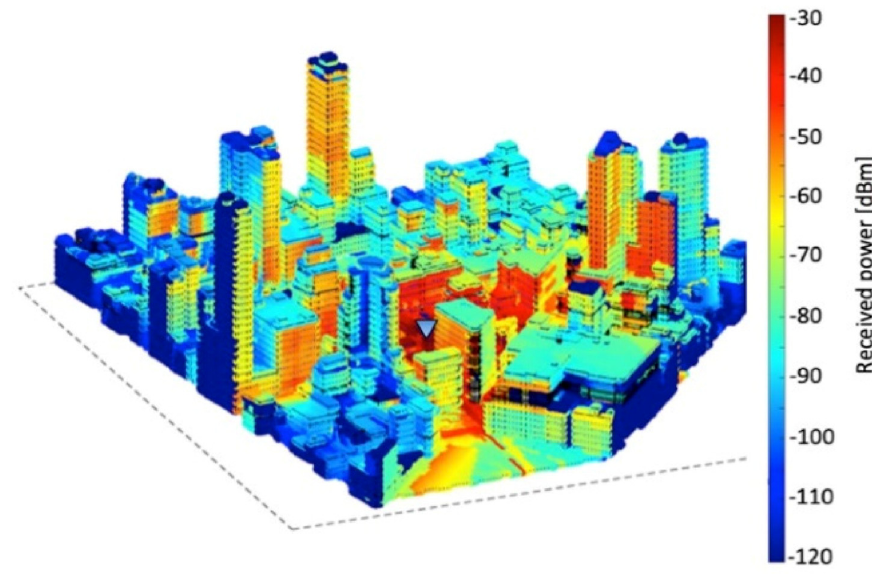
Figure 2. Example of 3D radio coverage prediction in the San Francisco environment.